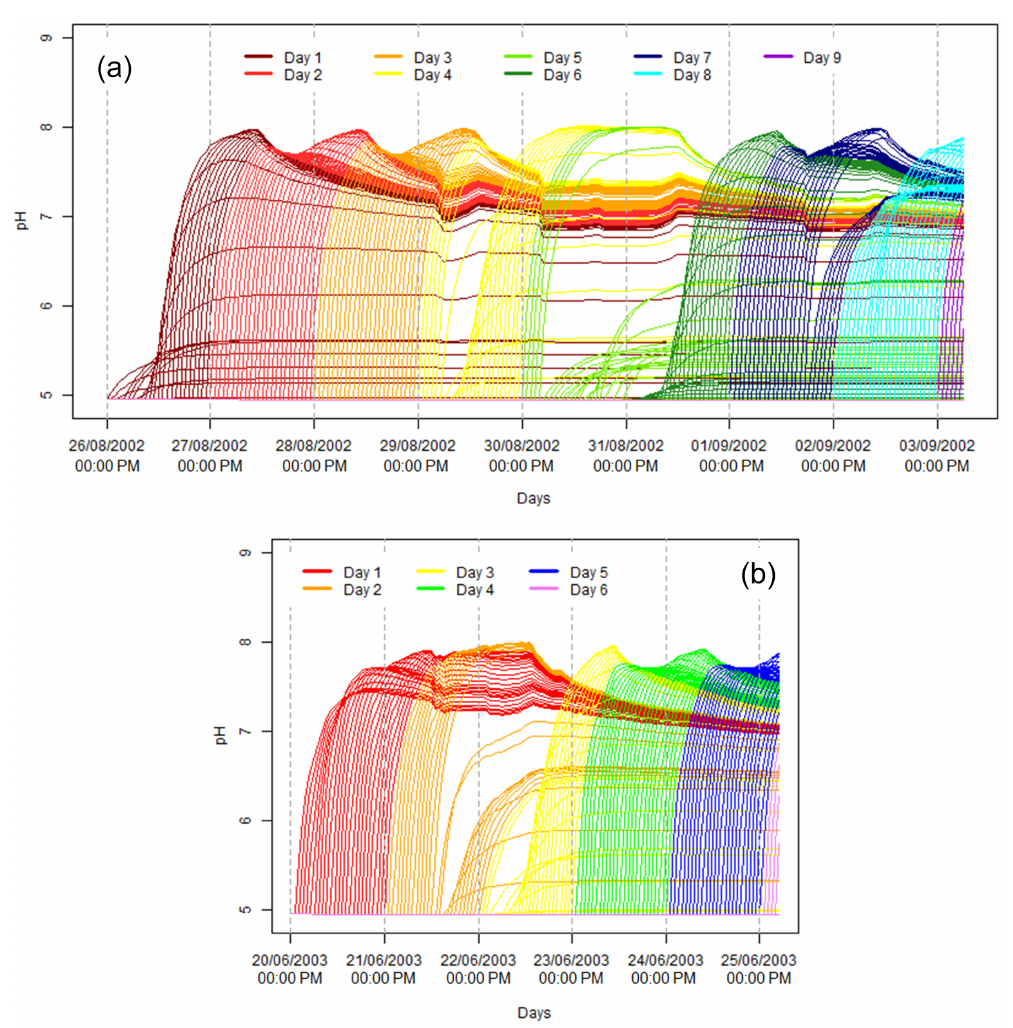
Figure 12. Simulated soil pH in the NH 3 source layer under urine patches deposited in the same time step in the modelling periods, P2002 (a) and P2003 (b) in the baseline experiments with GAG_field. The different colours indicate the days of the urination events. Each line indicates soil pH under urine patches deposited in a given time step, while the different colours indicate the days of the urination events. Table 4. Results from simulations with GAG_patch, testing the effect of pH( t 0 ) (initial soil pH), θ fc (field capacity) and θ pwp (permanent wilting point) on the sensitivity of the total NH 3 emission to β (buffering capacity). Input data were applied from the baseline simulation with GAG_patch (Móring et al., 2016), except for the parameters denoted in the table with a different font style. Bold values are taken from the input data for the baseline simulations with GAG_field, and italics denote a situation when the water content was assumed to be halfway between the field-scale values of θ fc and θ pwp . The sensitivity was expressed as the percentage difference in the original NH 3 emission derived with the given model settings with GAG_patch (listed also in the table for every model